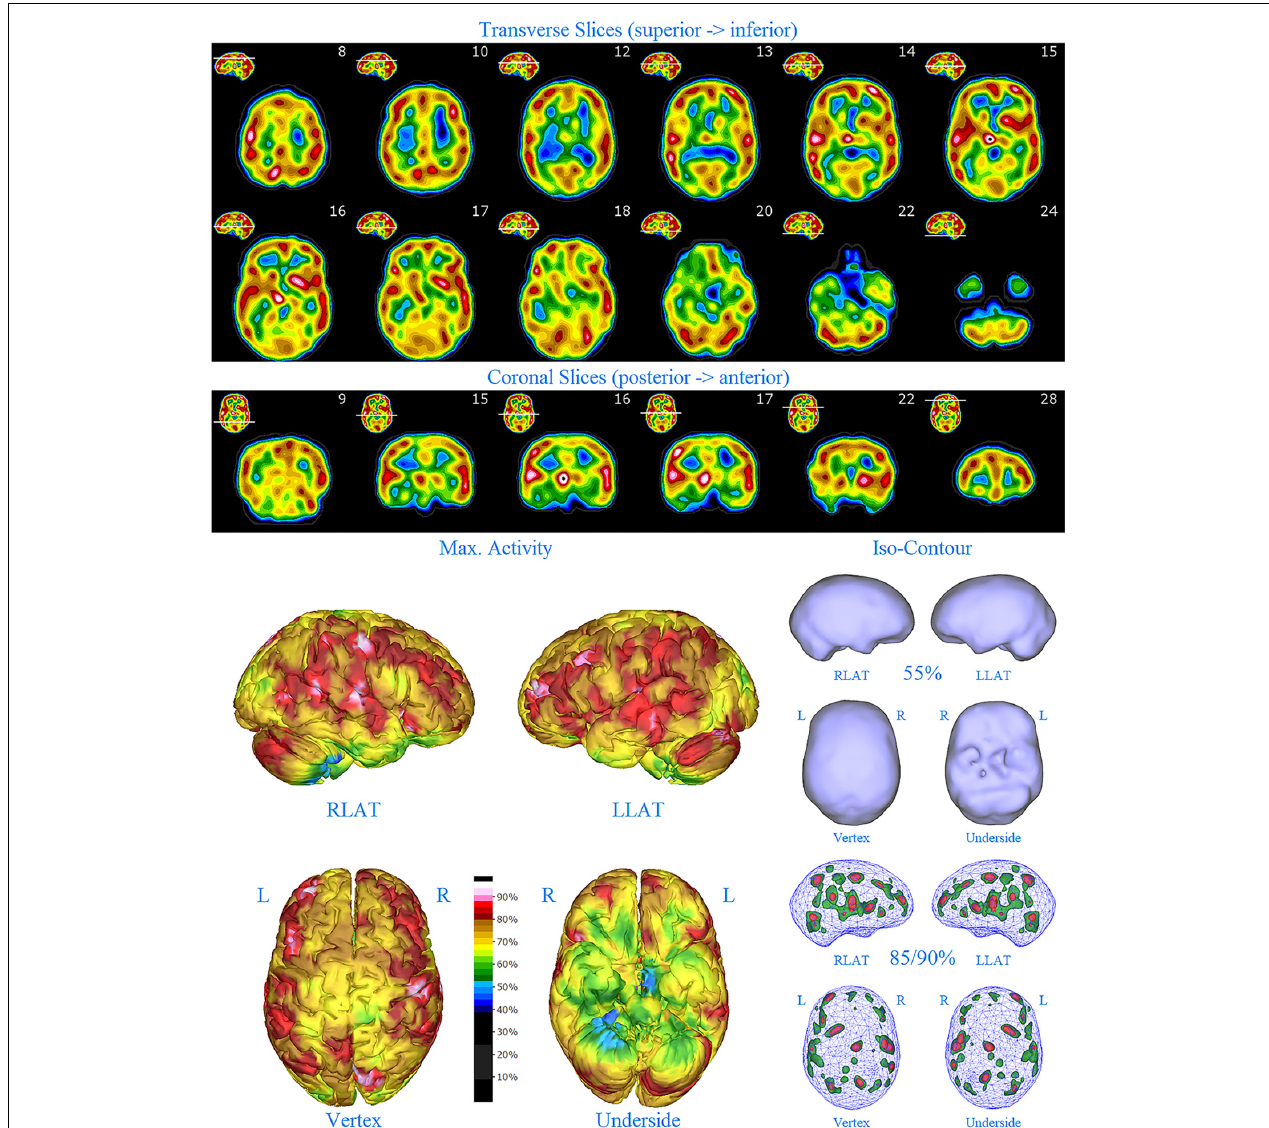
FIGURE 8 | First perfusion SPECT scan of Patient E. Arrangement, color scales, and views are identical to Figure 1 . Anatomical structures such as the thalamus are positioned similarly to the scan shown in Figure 2 . Labeling was eliminated to avoid obscuring the scan details. Perfusion of the thalamus is intensely increased and asymmetrical. Multiple cortical areas of increased perfusion are seen throughout the cerebral